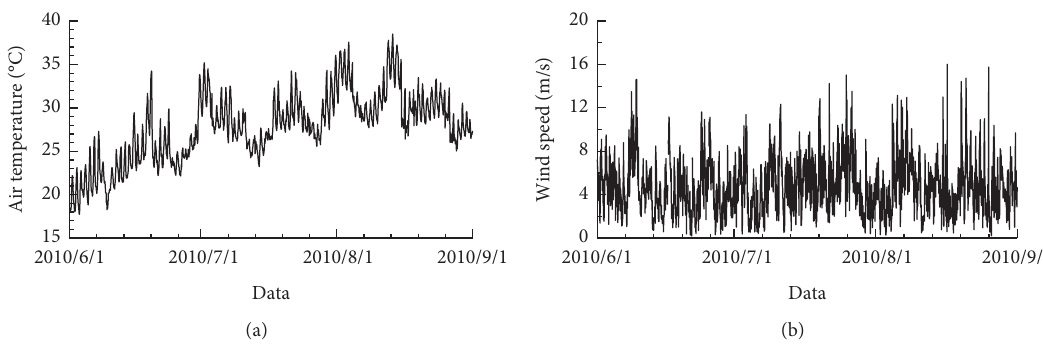
Figure 3: Hourly environmental records for the period from June 1 to August 31, 2010: (a) air temperature and (b) wind